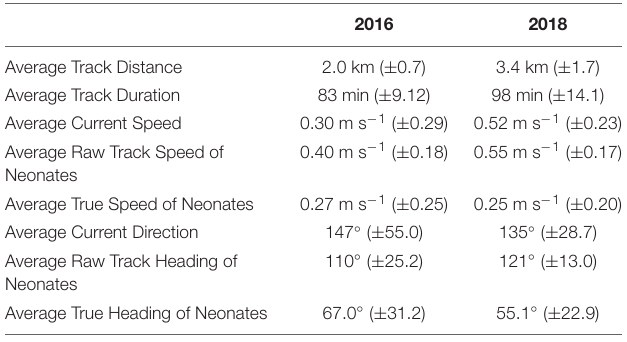
Columns show mean values and standard deviation of values in parentheses, for each